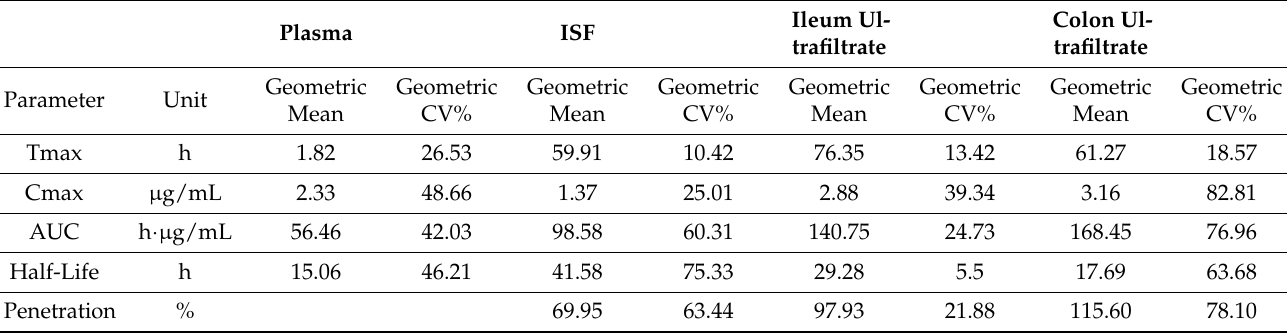
Figure 3. The drug concentration of florfenicol over time for plasma, interstitial fluid, ileum, and colon ultrafiltrate for the steers administered 40 mg/kg of florfenicol subcutaneously once. The points represent the means with standard error bars. Table 2. Selected PK parameters following analysis for the steers administered 20 mg/kg florfenicol IM q48 h twice. The geometric mean and geometric CV% are provided. T max : time to maximum concentration; C max : the maximum drug concentration; AUC: area under the time–concentration curve.